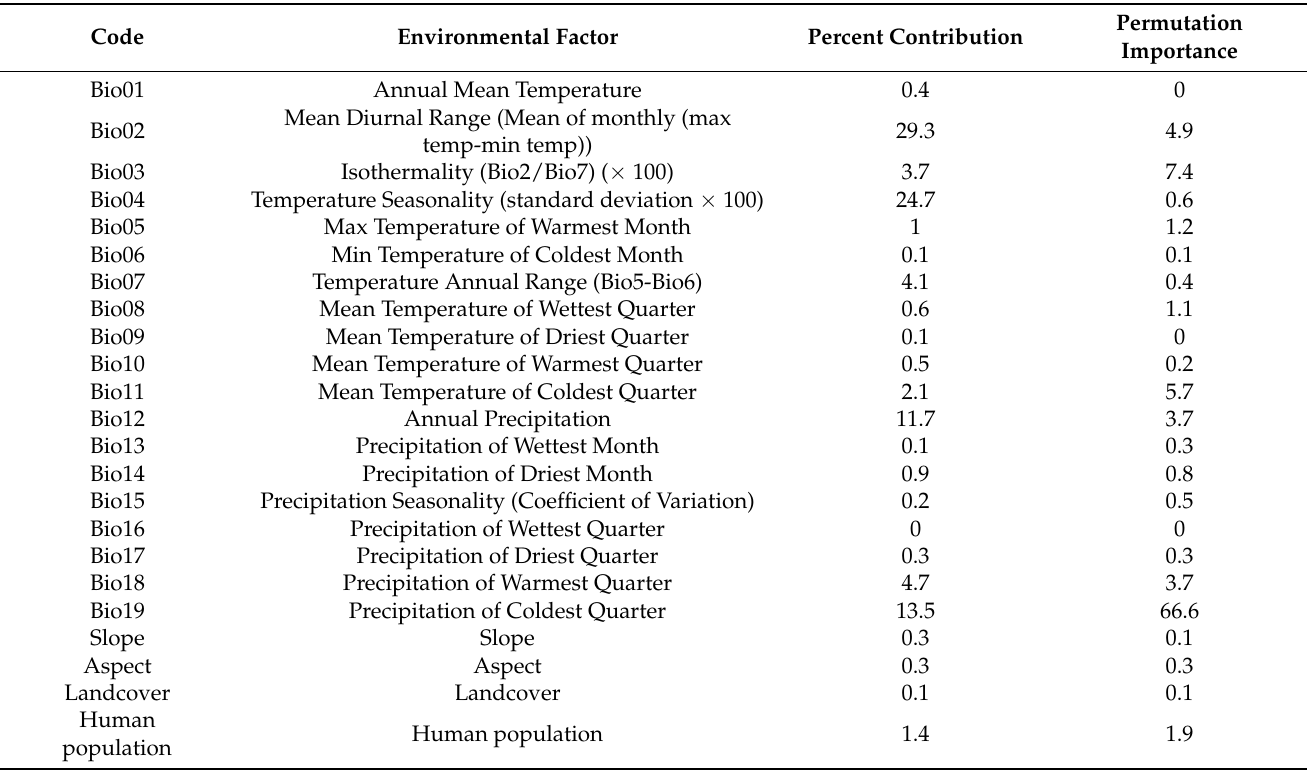
Table 2. Contributions of the environmental variables to the MAXENT models using the 19 bioclimatic variables as well as slope, aspect, land cover, and